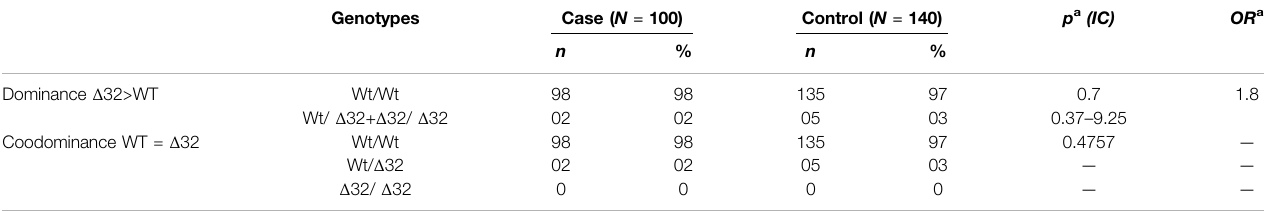
TABLE 5 | study association of CCR5 Δ 32 deletion with CRC: a case control study.